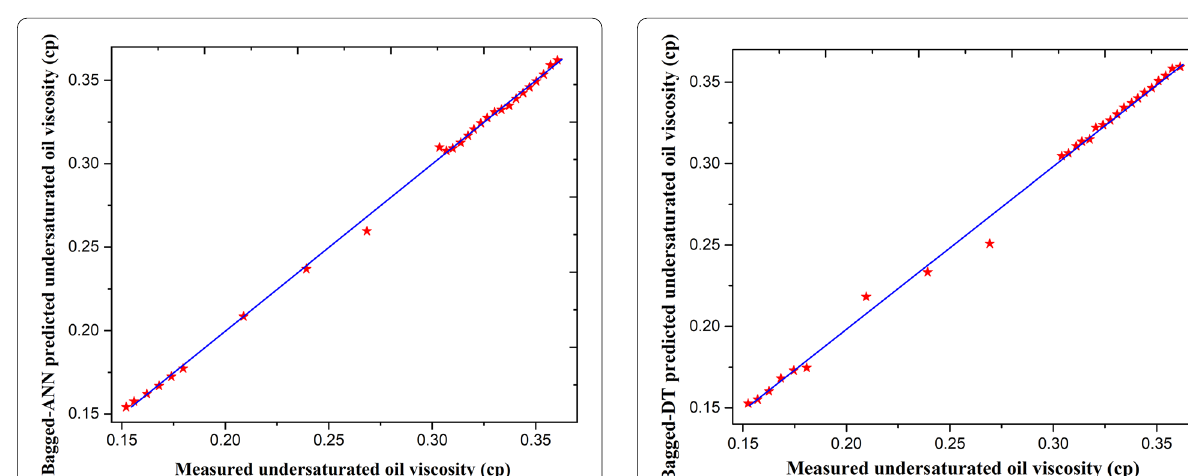
Fig. 12 Cross plot of bagged-DT predicted values versus measured values